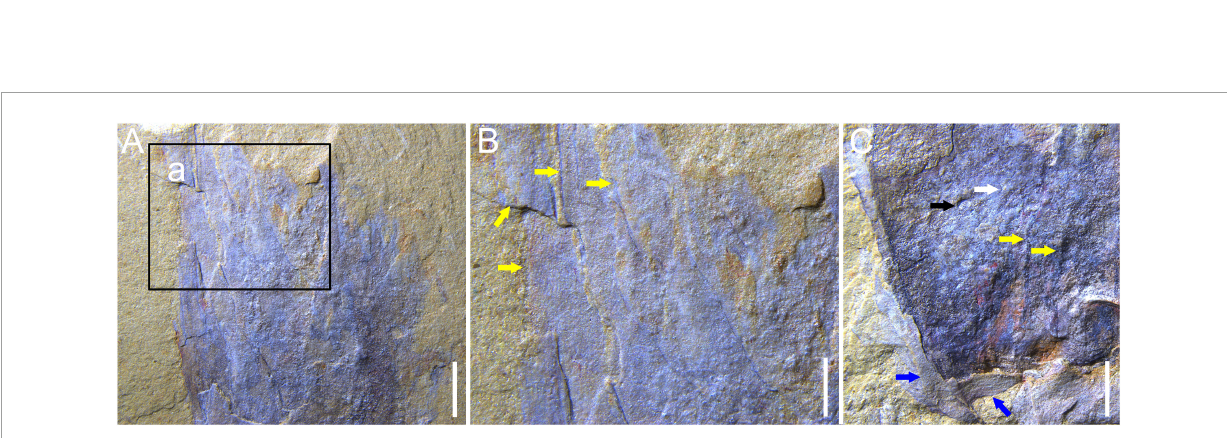
FIGURE2 The unnamed cnidarian-like metazoan (RCP-ZJ-0002). (A) Detail of the tentacle-like structures on the counterpart (position marked by frame b in Figure 1B ); (B) detail of the tentacle-like structures [position marked by frame a in panel (A) ]; yellow arrows indicate the thin and overlapped tentacle-like structures; (C) detail of the lower portion of the body on the part (position marked by frame a in Figure 1A ); white and black arrows indicate a bump and a depression, respectively, yellow arrows indicate longitudinal ridges; blue arrows indicate the sheath-like structure. The scale bars are 2 mm for panels (A,C) and 1 mm for panel (B)